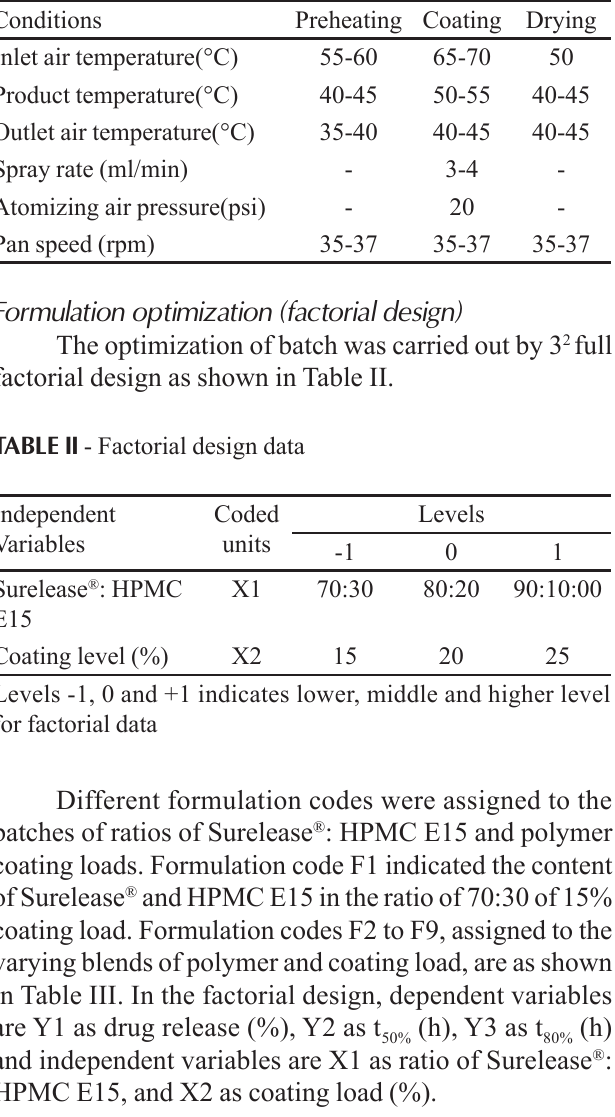
TABLE I - Coating parameters required during coating Conditions